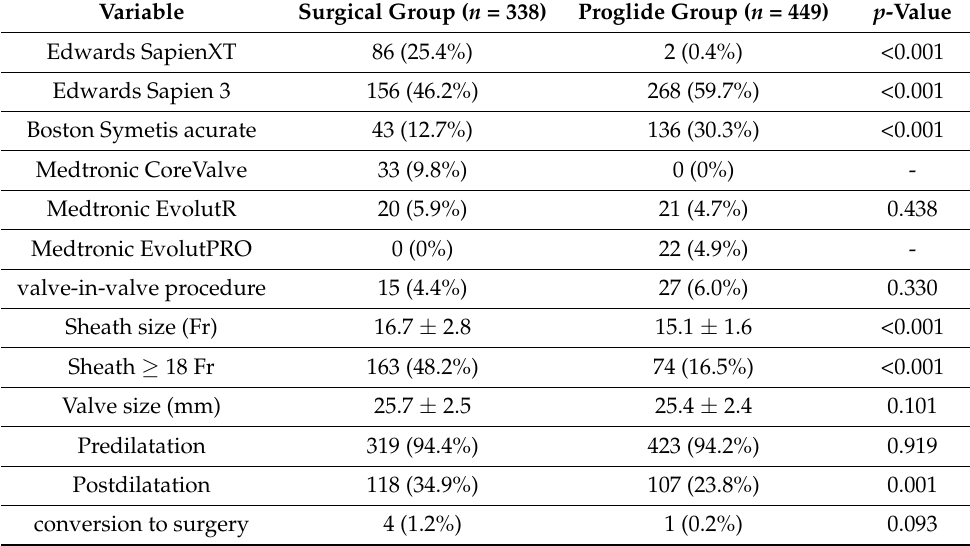
Table 2. Procedural